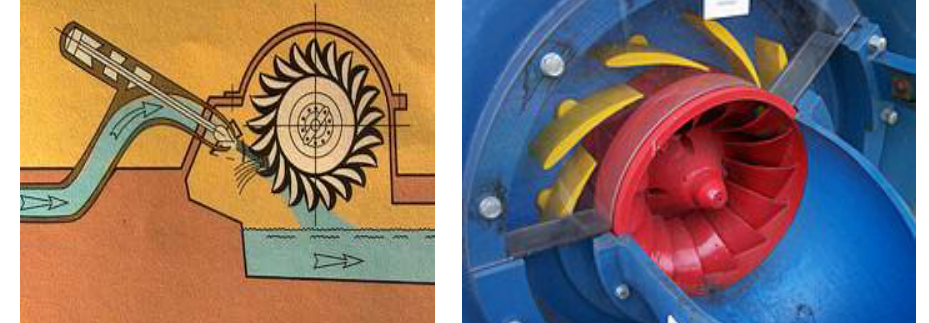
Figure 3 – Pelton turbine Рис . 3 – Ковшовые турбины Пелтона Слика 3 – Пелтонова турбина